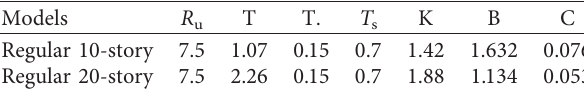
Table 2: Seismic parameters of